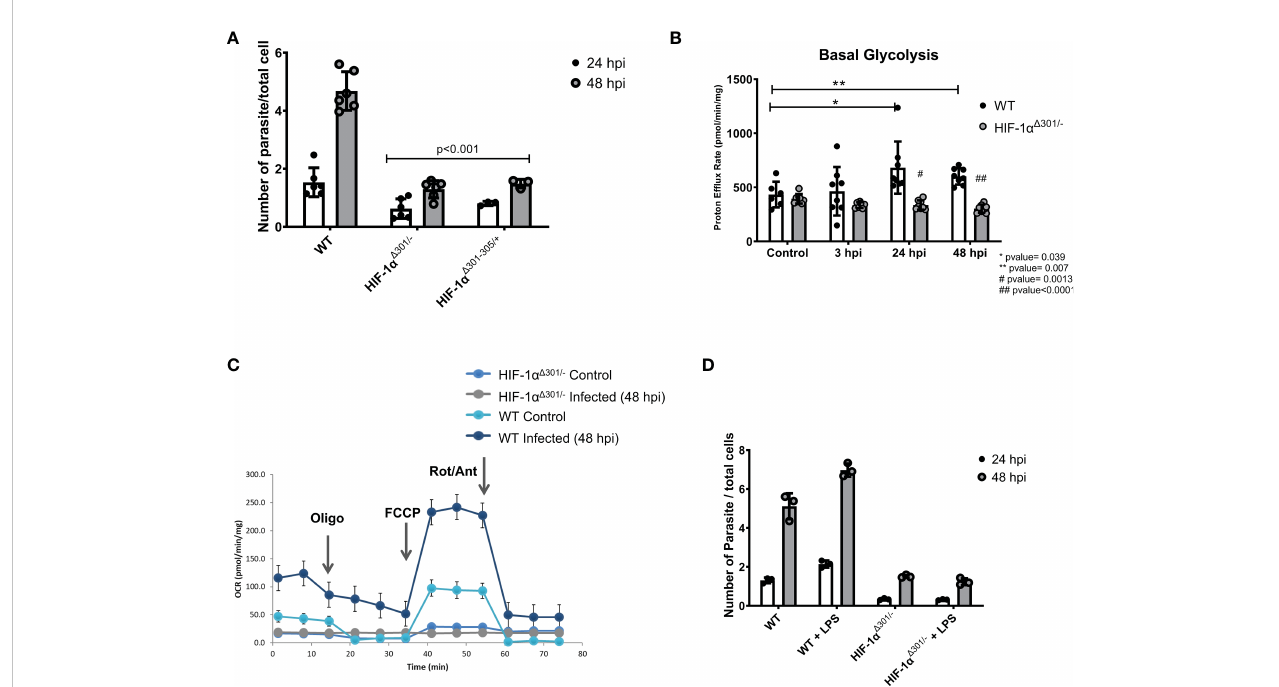
FIGURE 4 HIF-1 a is required for glycolytic switch after T. cruzi infection. (A) Two iPSC-CMs lines carrying HIF-1 a D 301/- (compound inframe deletion of amino acid 301 and a null allele) or HIF-1 a D 301-305/+ (a heterozygous inframe deletion of amino acids 301- 305) have lower infection and replicate rates compared to WT cells. (B) HIF-1 a D 301/- iPSC-CMs did not activate proton ef fl ux, an indicator of glycolytic activation. (C) Extracellular metabolic fl ux analyses demonstrated lower mitochondrial respiratory activity (oxygen consumption rate; OCR) in HIF-1 a D 301/- iPSC-CMs at 48 hpi compared to WT. (D) HIF- 1 a D 301/- iPSC-CMs were unresponsive to LPS-priming. Data re fl ects six (A, B) and three (C, D) independent replicates for each experiment. Statistical analyses used ANOVA test with Bonferroni correction and p-value<0.05 was considered signi fi